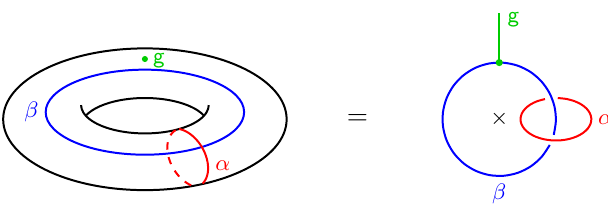
Figure 1 . Schematic notation for an arbitrary configuration of anyons on the torus, in the presence of a puncture g . The green line represents the vertical (time) direction, orthogonal to the